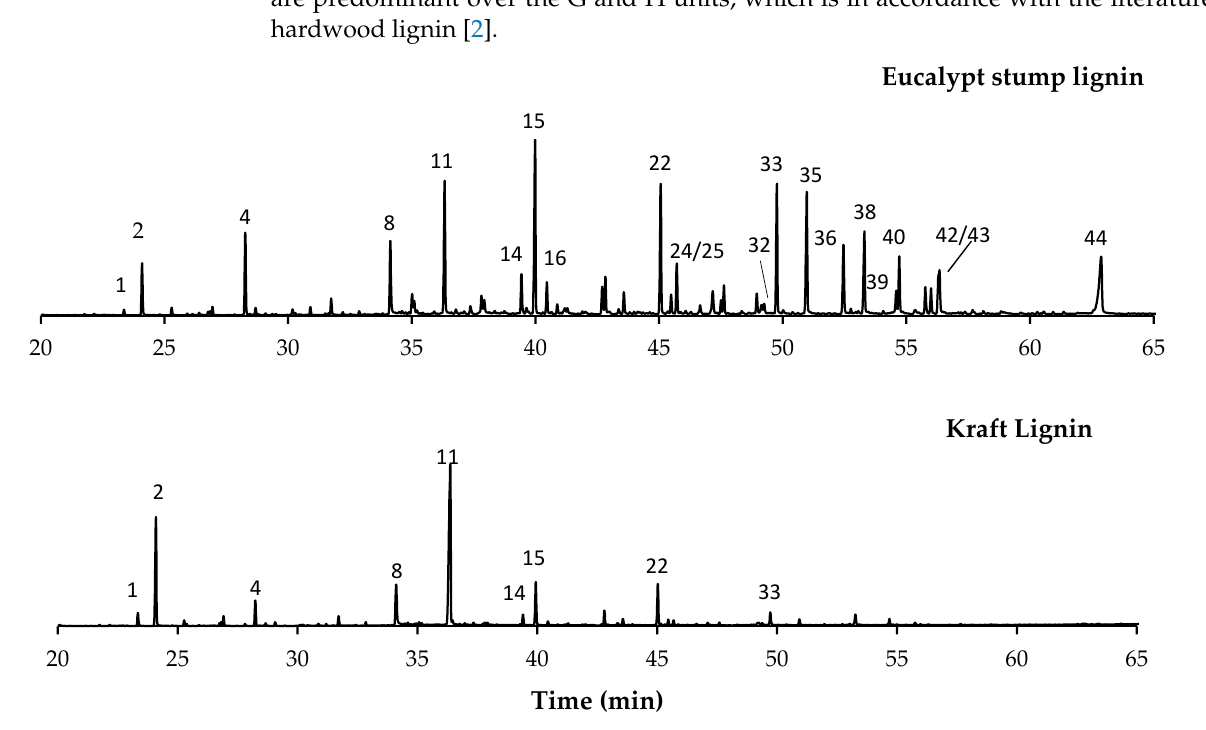
Figure 1. Pyrograms of the lignins from eucalypt stump and kraft lignin from poplar and beech (50:50).